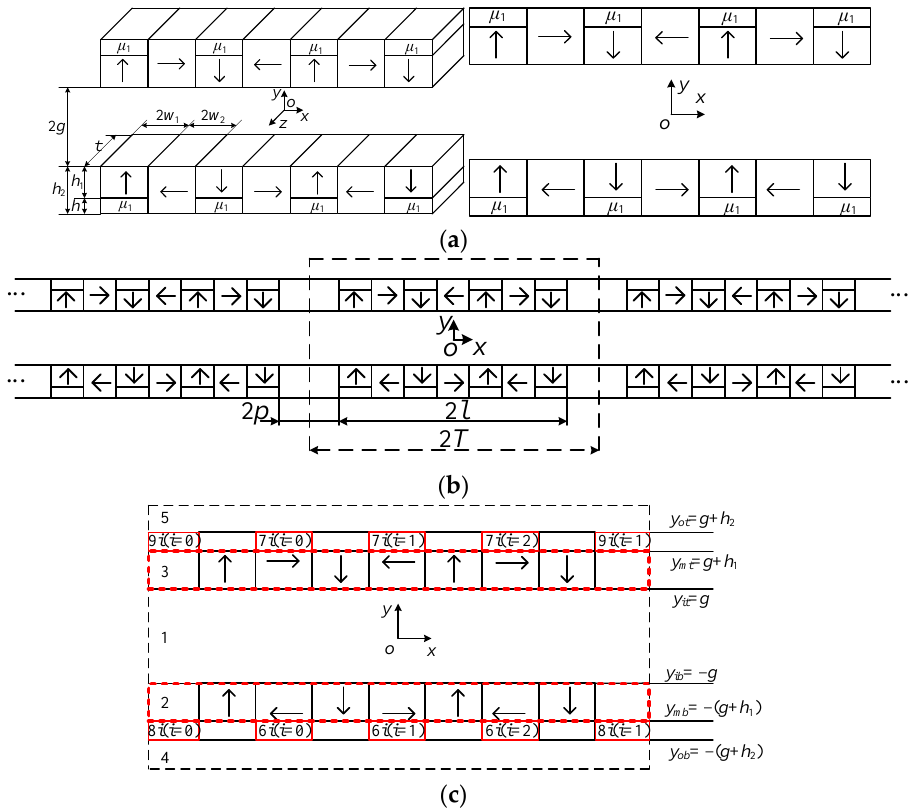
Figure 4. Equivalence process of the improved halbcah array structure: ( a ) Improved halbach array structure; ( b ) equivalent structure; ( c ) divided regions.